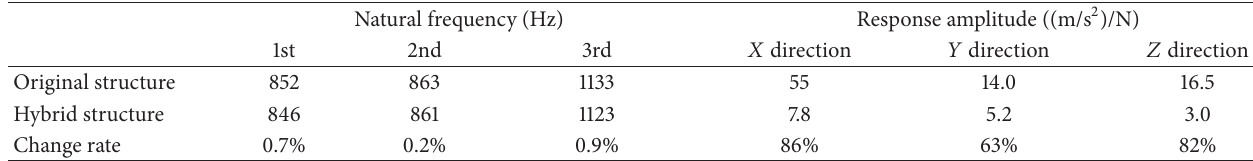
Table 3: Comparison of natural frequency and response amplitude for two structures. Natural frequency